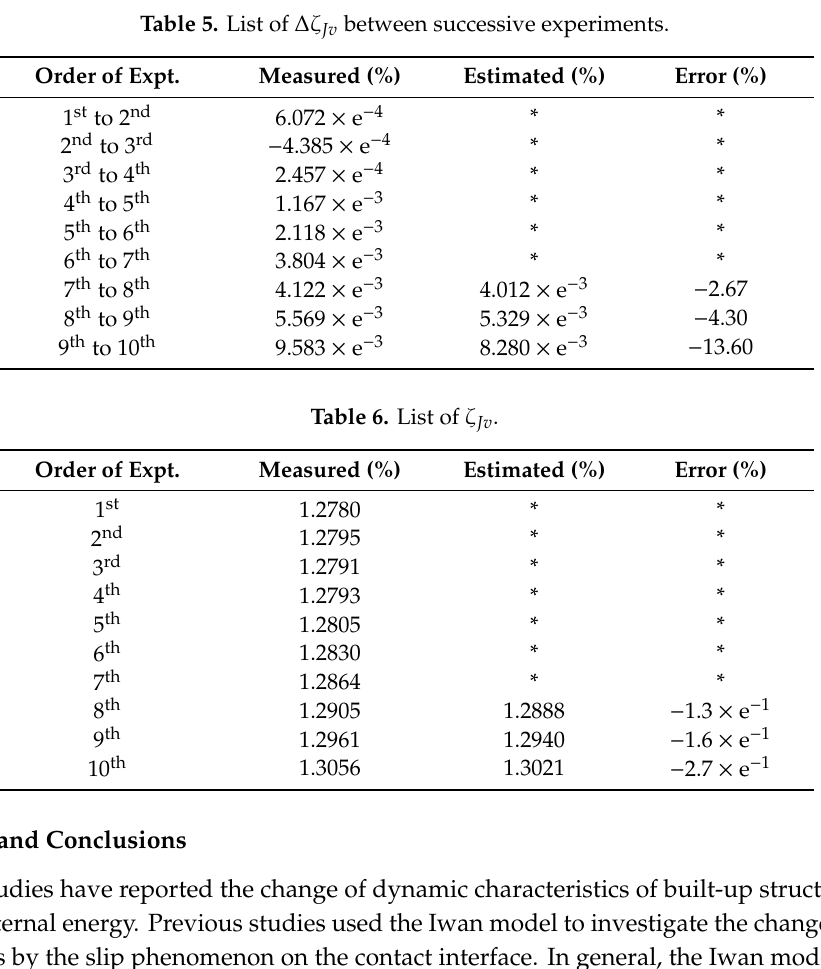
Table 5. List of ∆ ζ Jv between successive experiments. Order of Expt.